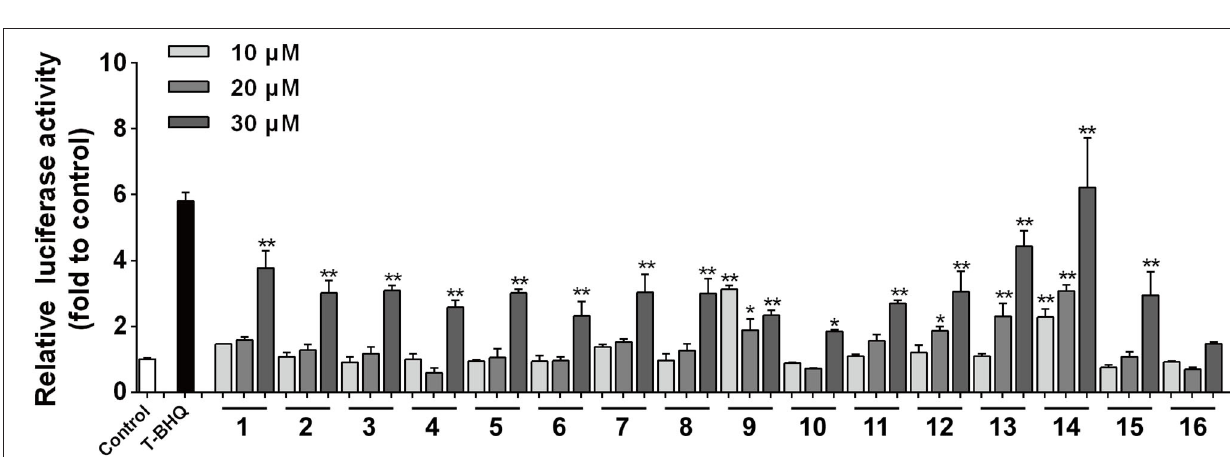
FIGURE 6 | The agonistic activities of compounds 1 – 16 on Nrf2 ( n = 3). All compounds showed concentration-dependent antioxidant activity. * p -value < 0.05 and ** p -value < 0.01. Compound 2 was obtained as a white amorphous